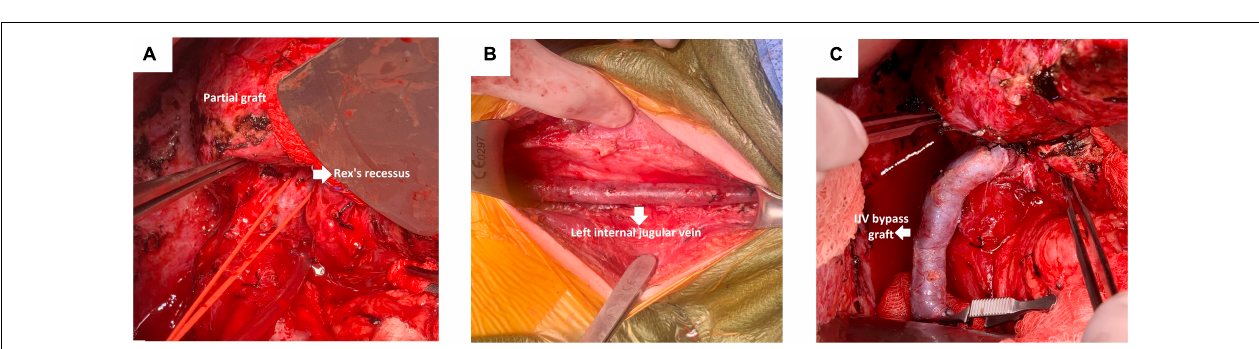
FIGURE 1 | Schematic representation of an MRB creation. (A) Meso-Rex post-LT with whole liver grafts. (B) Meso-Rex post-LT with partial grafts (LLS). IJV, internal jugular vein; IMV, inferior mesenteric vein; IVC, inferior vena cava; LHV, left hepatic vein; LPV, left portal vein; MHV, middle hepatic vein; RHV, right hepatic vein; RPV, right portal vein; SMV, superior mesenteric vein; SV, splenic vein.